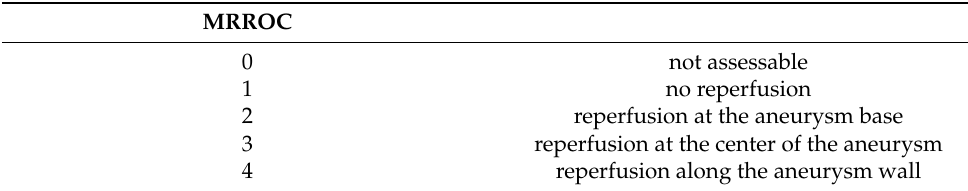
Table 1. Modified Raymond–Roy occlusion classification (MRROC) for intracerebral aneurysms treated via endovascular coiling.